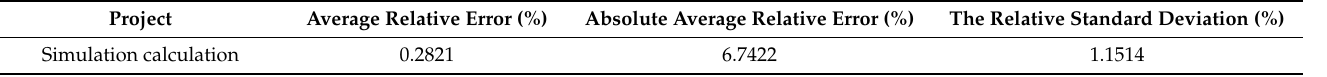
Table 7. Error analysis of the results of pressure recovery simulation calculation and test